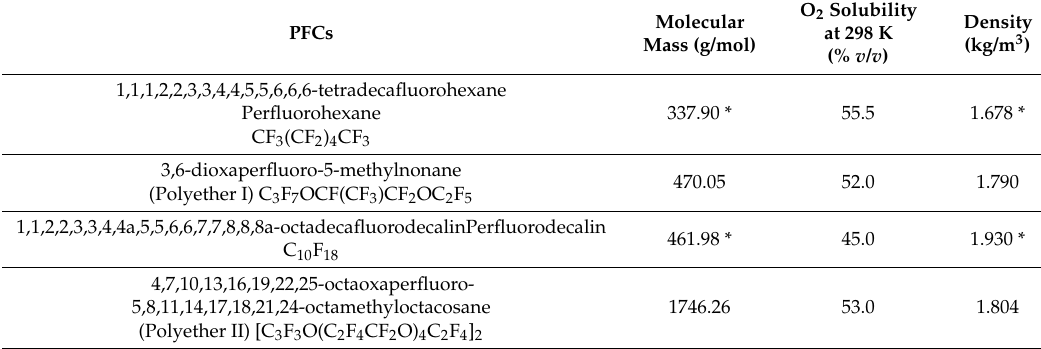
Table 1. Physico-chemical properties of perfluorocarbon compounds (PFCs) used in this study.